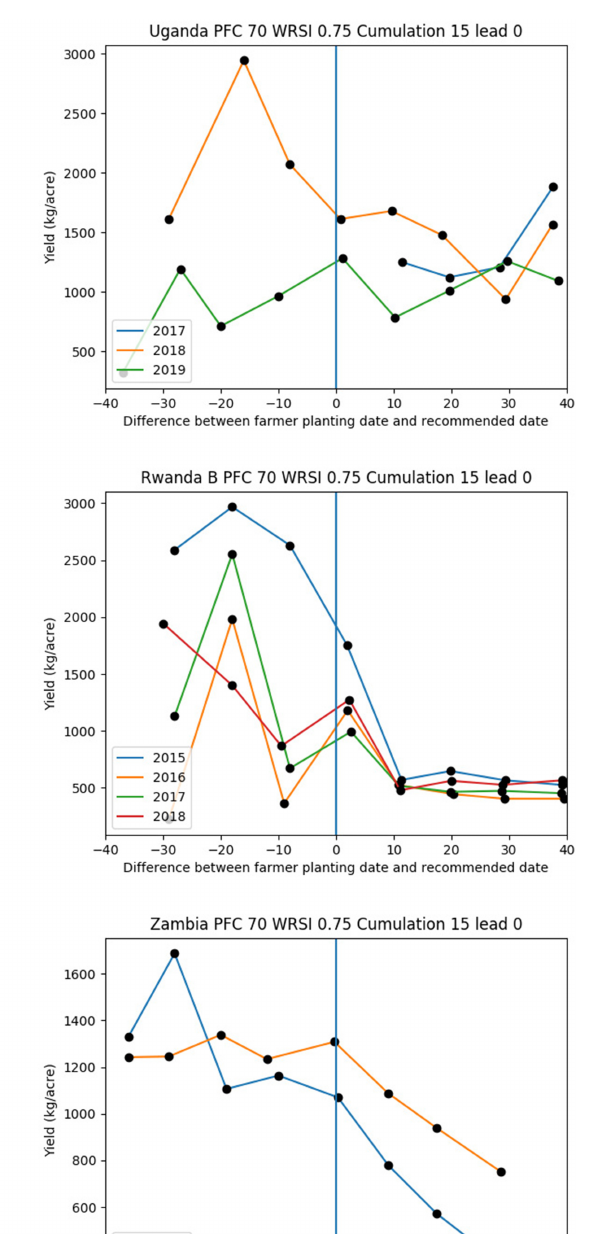
severe dry spell (Supplementary Figure 1). Analogously, early planters achieved high yields in Uganda during 2018, but in other years, these planters were affected by severe dry spells (Supplementary Figure